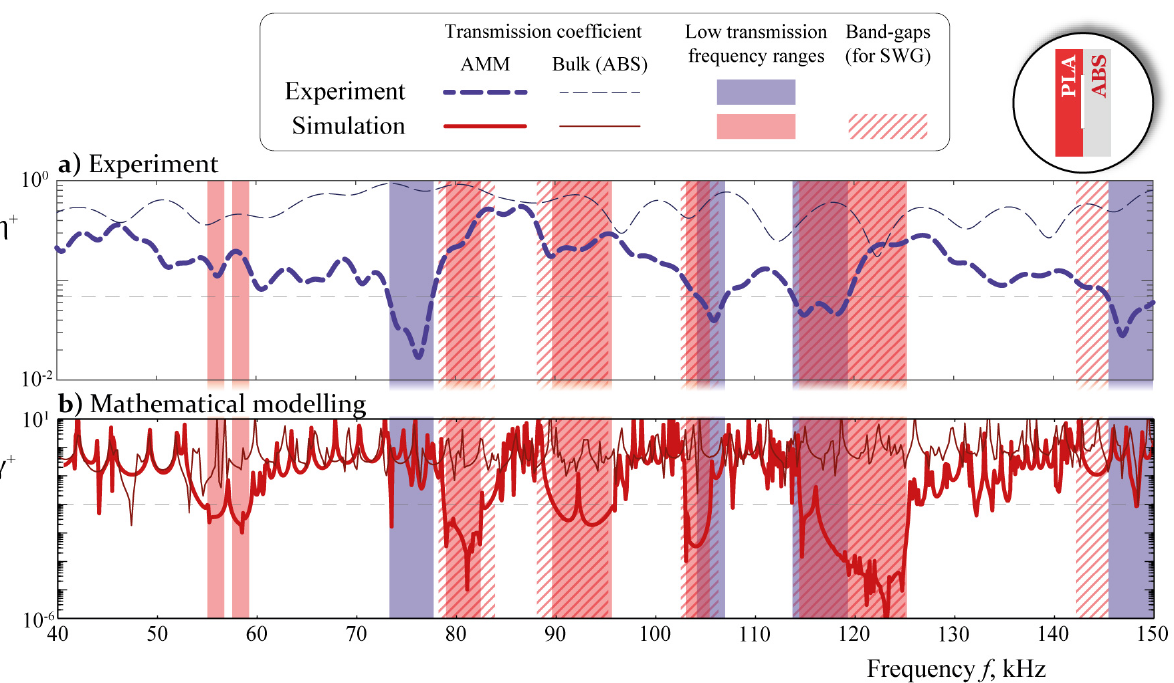
Figure 8. Experimental ( a ) and theoretical ( b ) and transmission coefficients η + ( f ) and γ + ( f ) , and the corresponding band-gaps for AMMs with central